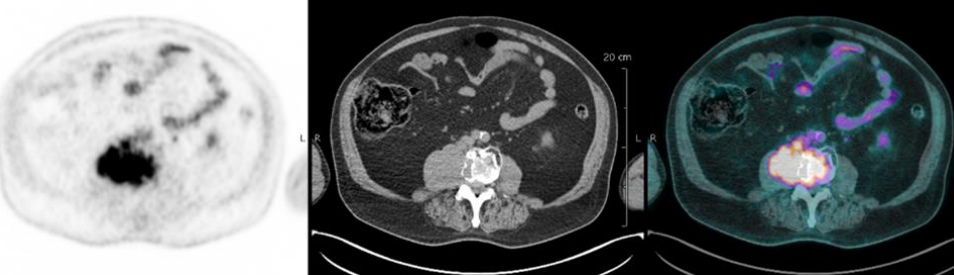
Figure 2. Hypermetabolic lytic lesion of L3, contiguously invading adjacent soft tissues.